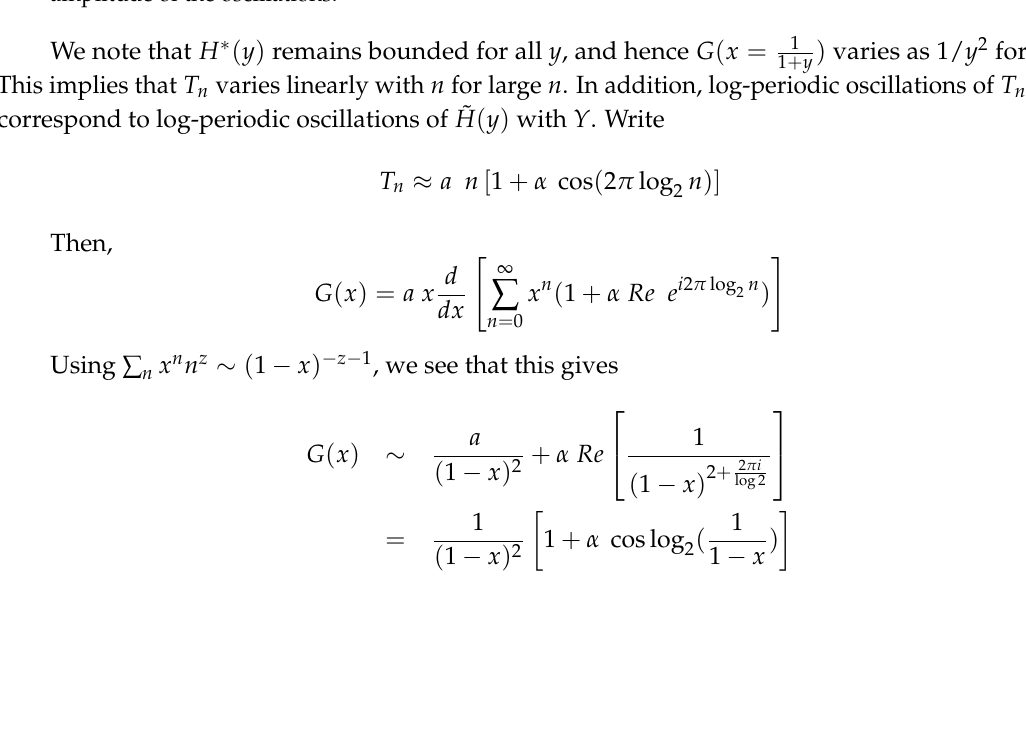
Figure 3. Log-periodic oscillations in the function H ∗ ( y ) as a function of log numerically summing the series in Equation (14), about the mean value 1.44269504089. Note the small amplitude of the